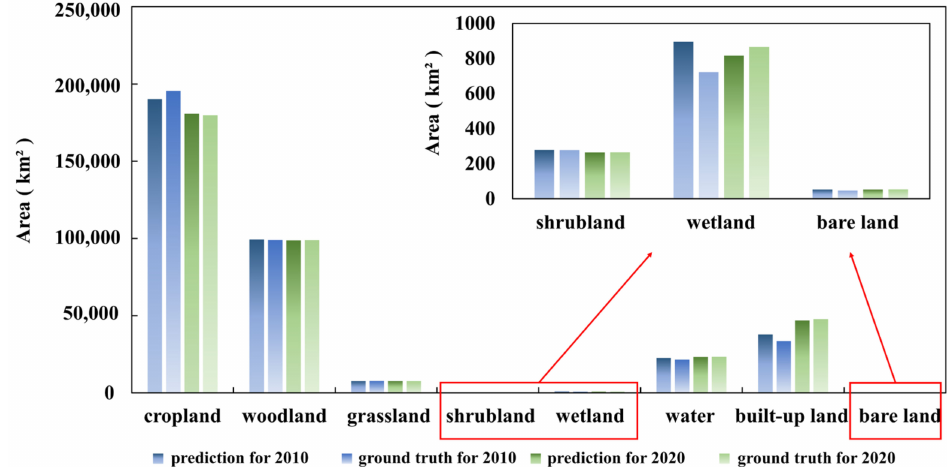
Figure 6. Comparison of land use simulation of Markov with existing data.